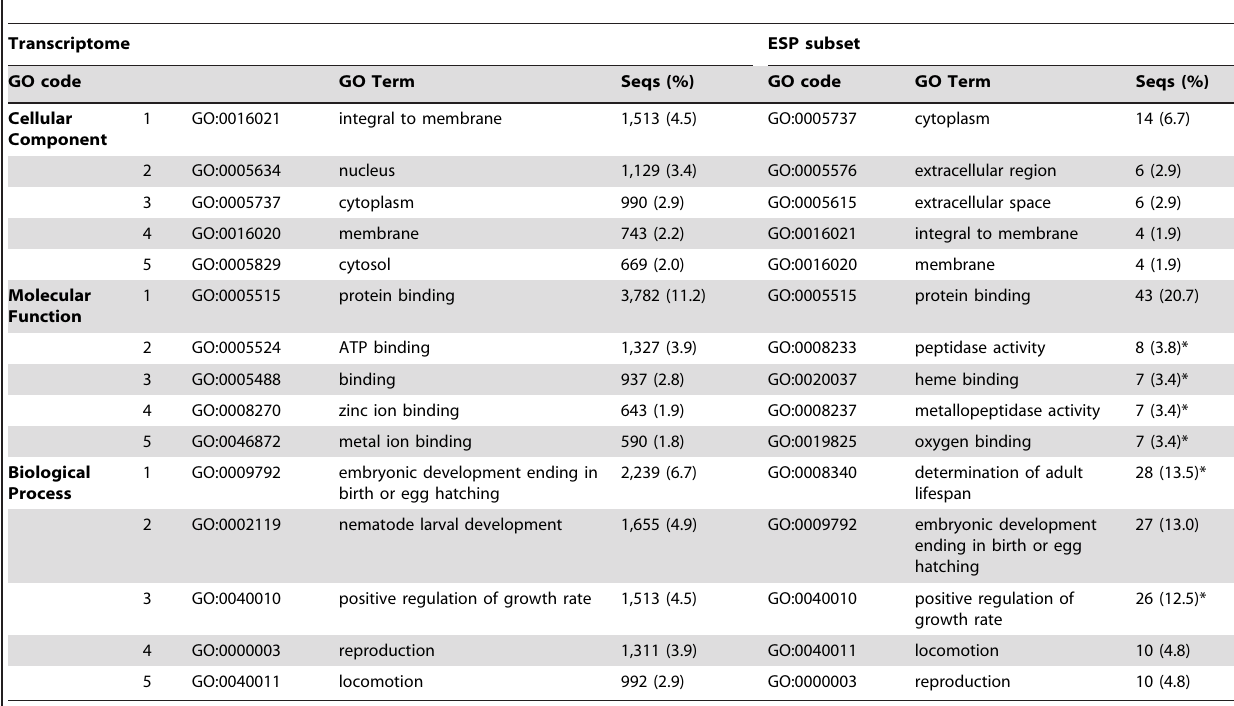
Table 2. Most abundant GO terms mapped and annotated using Blast2GO in the transcriptome and ESP datasets.